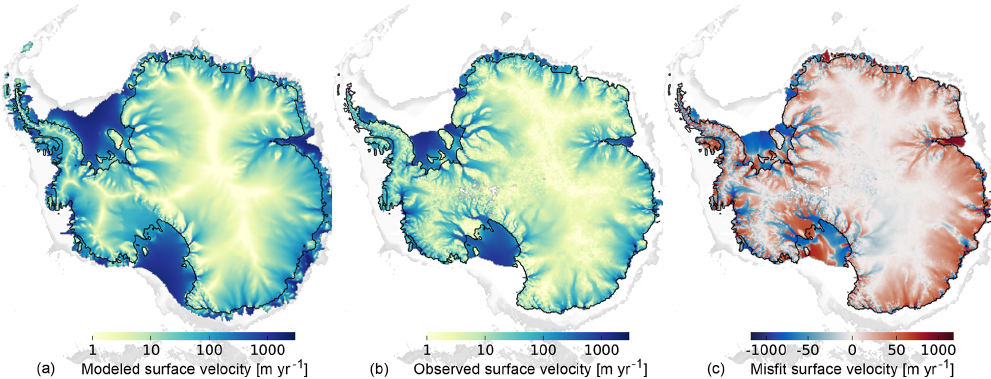
Figure 14. Comparison of present-day surface velocity in best-fit ensemble simulation (a) with respect to observations (middle; Rignot et al., 2011), all on log scale. Greenish shading indicates slow-flowing regions and ice divides; blueish shading indicates regions of fast ice flow within ice shelves and far-inland-reaching ice streams. Model–observation difference is shown for observed glacier- ized area in (c) , RMSE for surface velocities is 35myr − 1 and mean misfit with respect to observational uncertainty is 66myr − 1